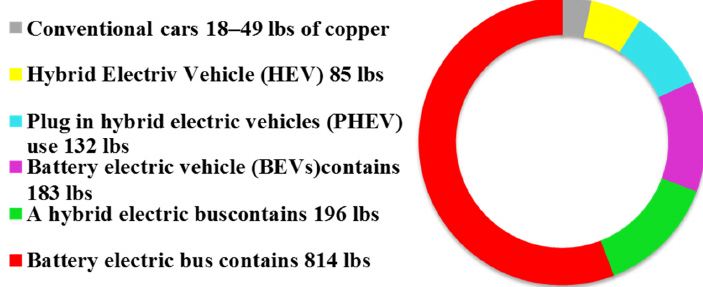
Figure 1. Copper use by different types of vehicles (adapted) [4].